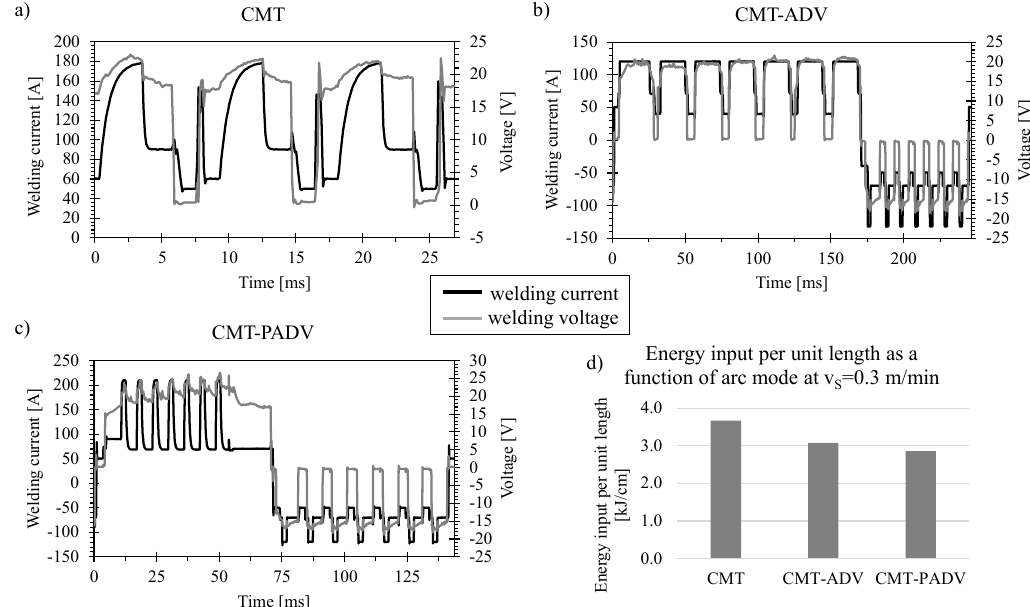
Figure 6. Current and voltage characteristics of ( a ) Cold Metal Transfer (CMT), ( b ) CMT advanced (CMT-ADV) and ( c ) CMT pulse advanced (CMT-PADV) and ( d ) the energy input per unit length as a function of the arc mode at a welding speed of v S = 0.3 m/min.